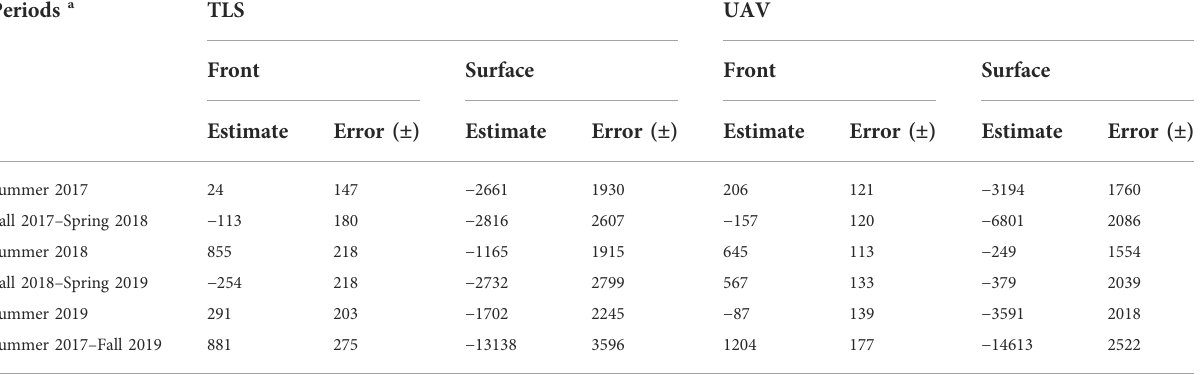
TABLE 6 Volume change (cubic metres) estimates derived from repeated TLS and UAV